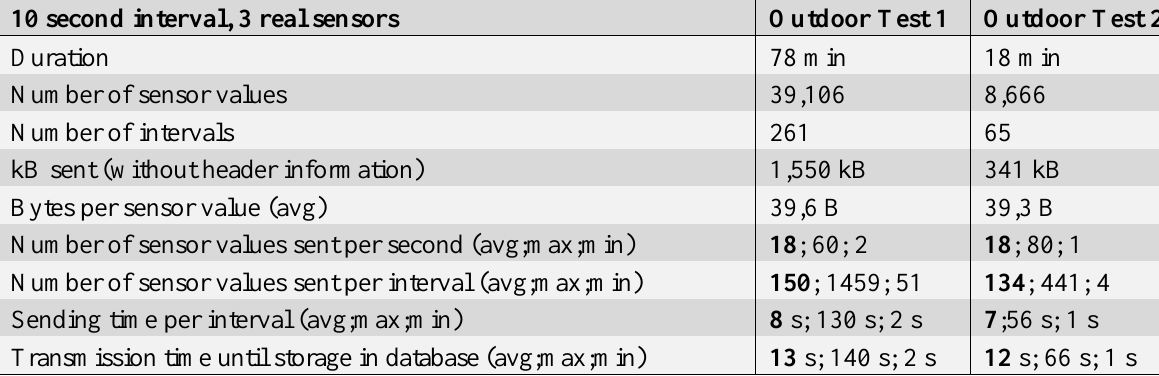
Table 4 . Transmission results of the outdoor